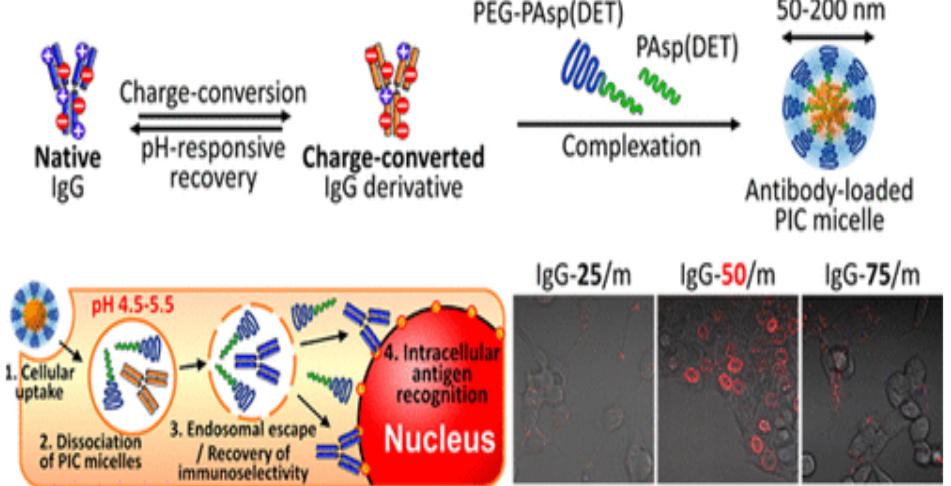
Figure 8. Representation of the formation of IgG-containing PEC micelles ( right ). Observation of in vitro IgG PEC micelle delivery to C26 murine colon carcinoma cells after 24 h incubation. ( left ) Adapted with permission from [65], with permission from the American Chemical Society.